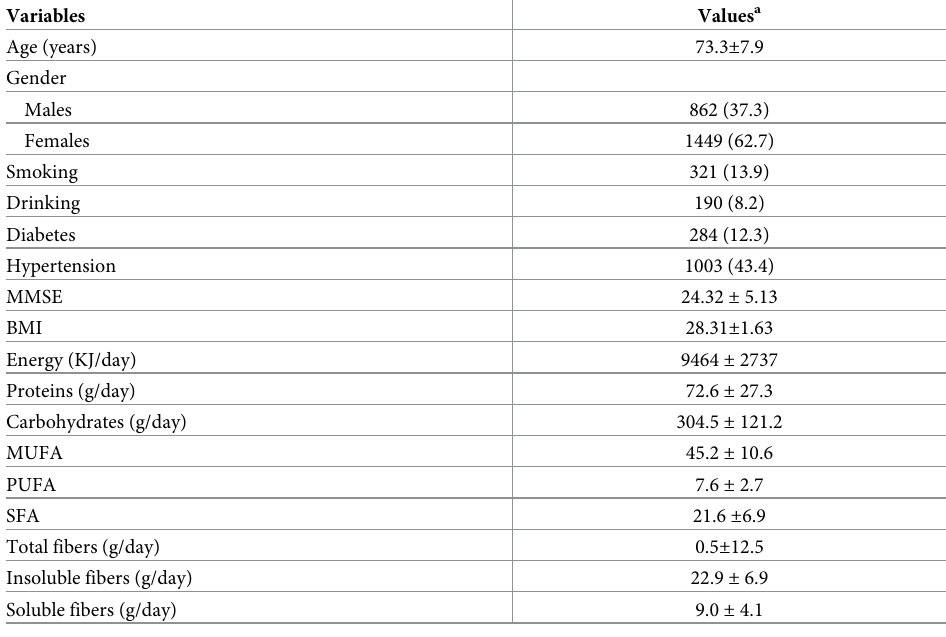
Table 1. Demographic and daily dietary intake of selected food groups among elderly ( n =